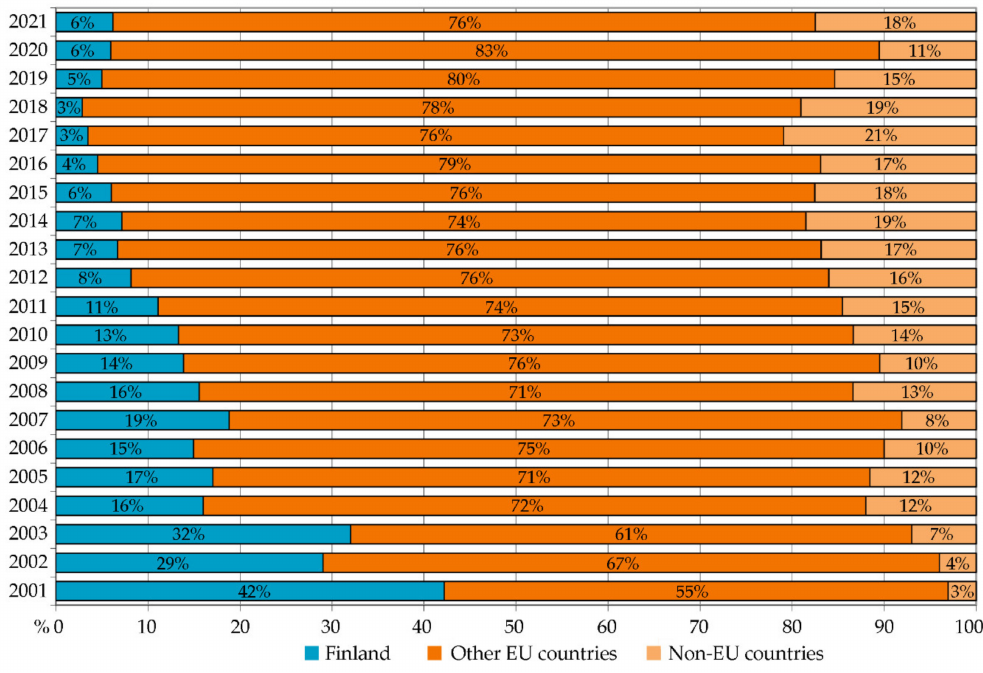
Figure 6. ThermoWood ® production statistics by